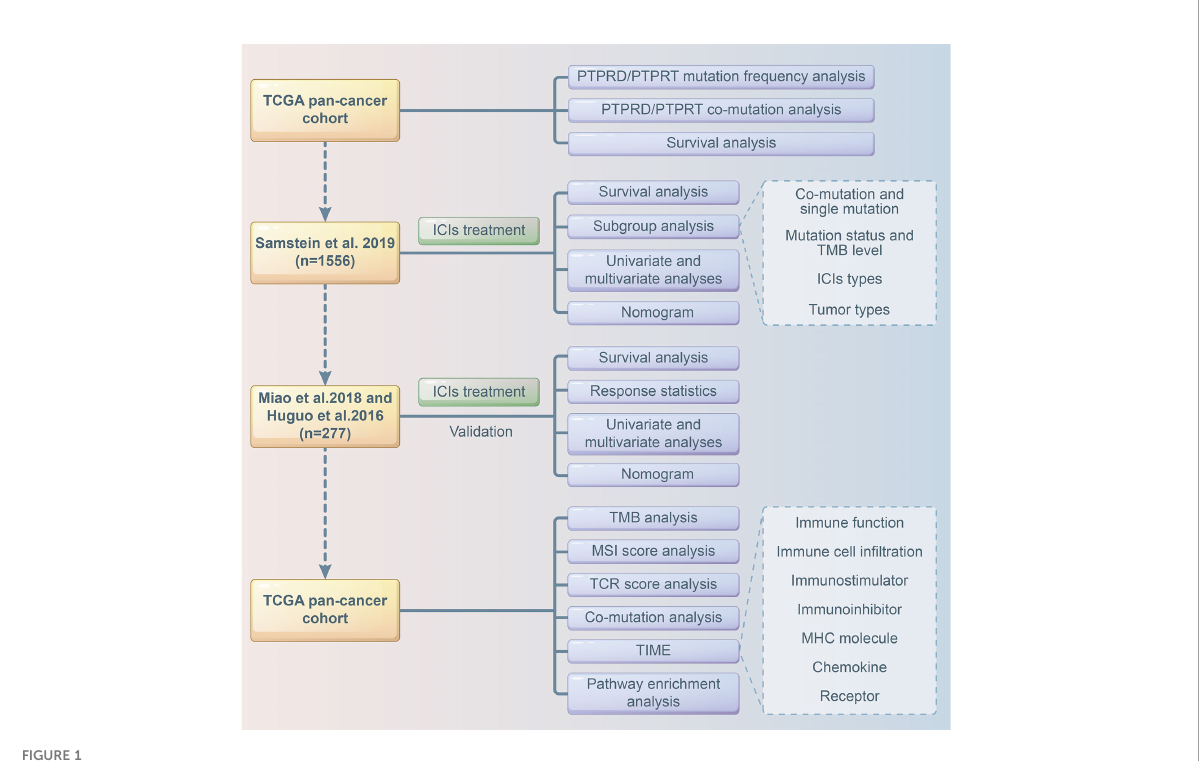
FIGURE 1 Flowchart of the study